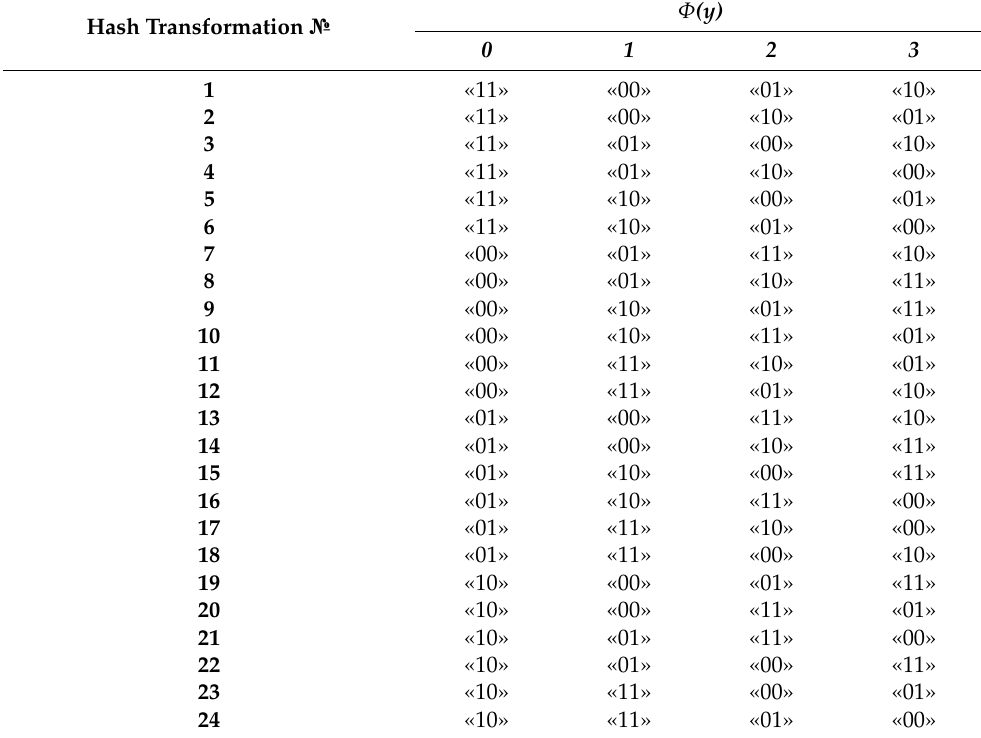
Table 1. Variants of the hashing transformations of the neuron response Φ (y) into a binary